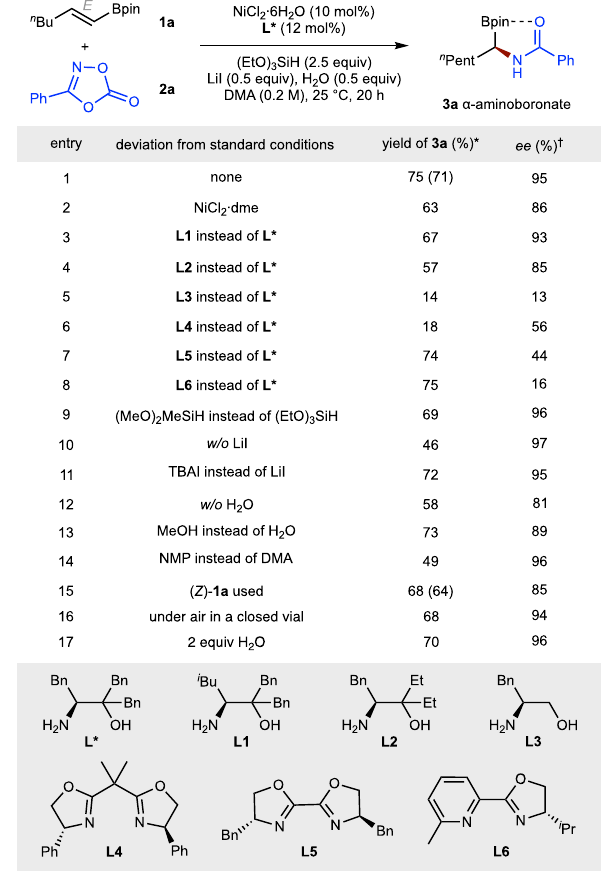
Fig. 2 | Variation of reaction parameters. *Yields were determined by gas chro- matography (GC) using n -dodecane as the internal standard, the yield within par- entheses is the isolated yield and is an average of two runs (0.20mmol scale). † Enantioselectivities were determined by HPLC analysis. Bpin, pinacol boronic ester; DME, 1,2-dimethoxyethane; TBAI, tetrabutylammonium iodide; DMA, N,N ′ - dimethylacetamide; NMP, N